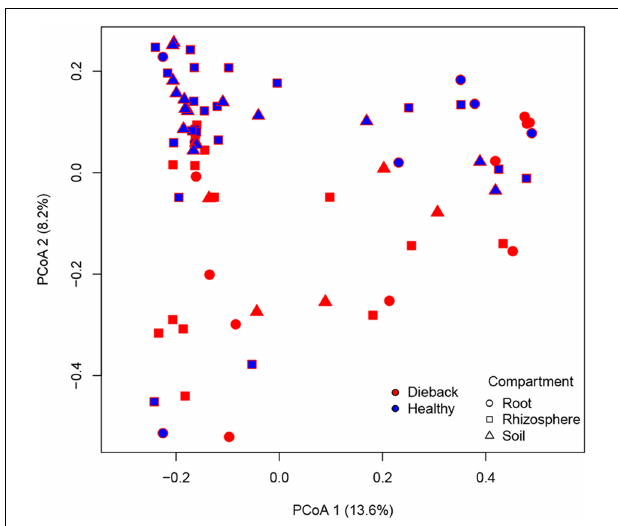
FIGURE 5 | Principal coordinates analysis (PCoA) plot based on Bray–Curtis matrix. Samples are colored based on RDBS occurrence.